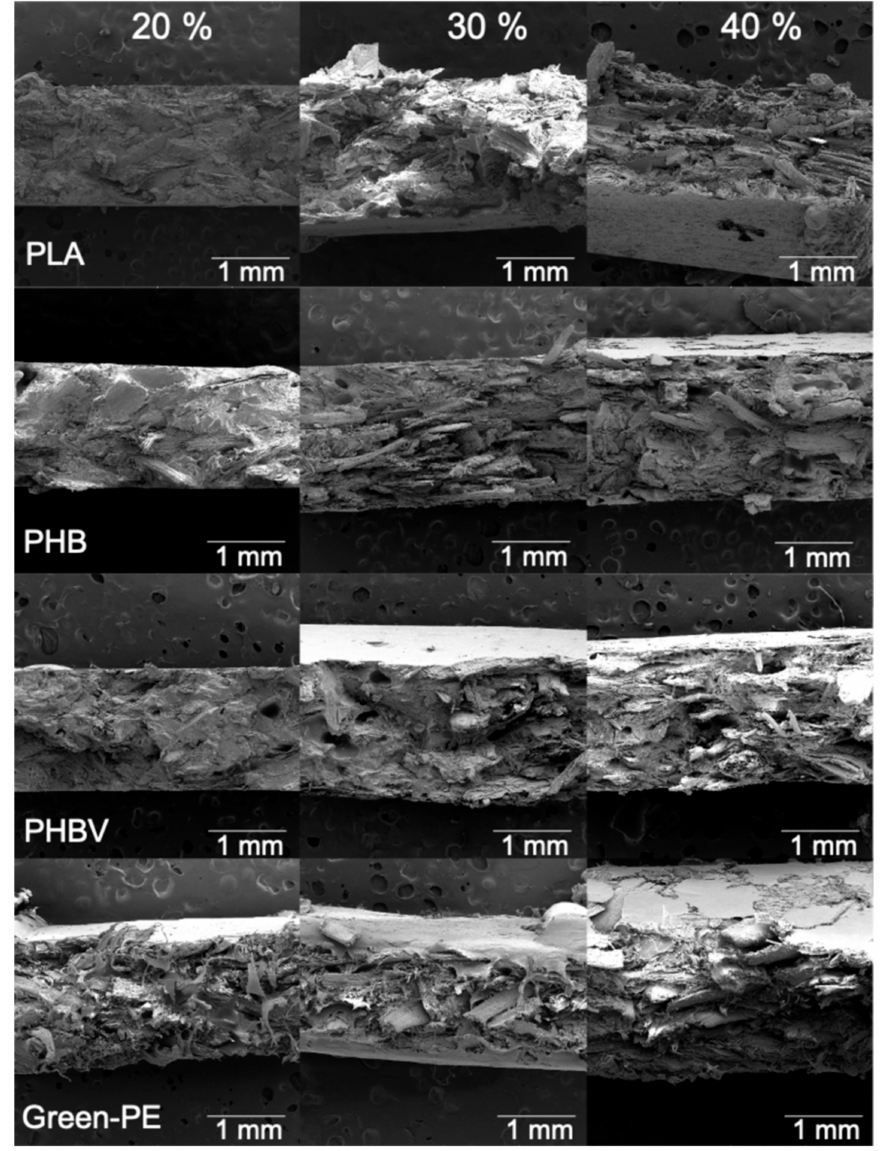
Figure 6. SEM micrographs of the biocomposites.